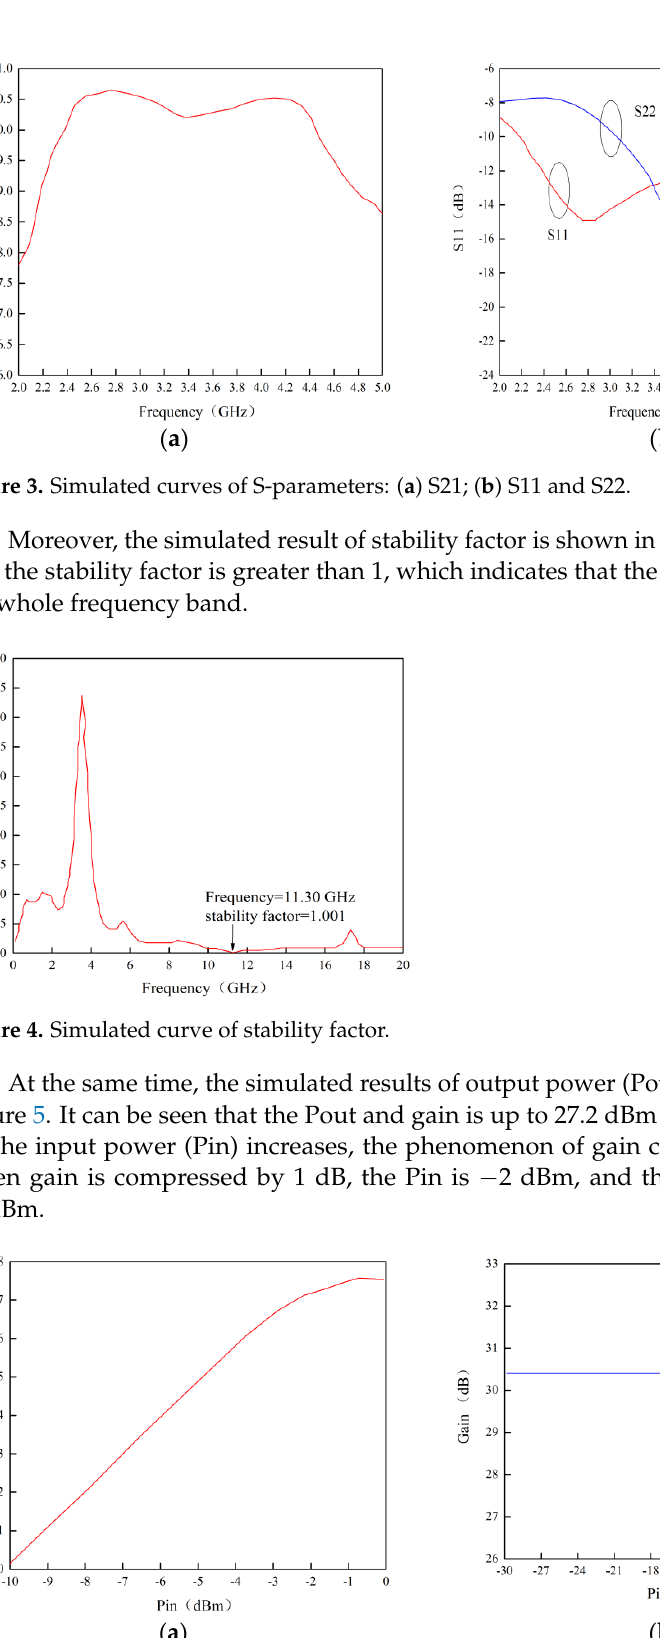
Figure 5. Simulated curves of RF output characteristics ( a ) Pout; ( b ) gain.